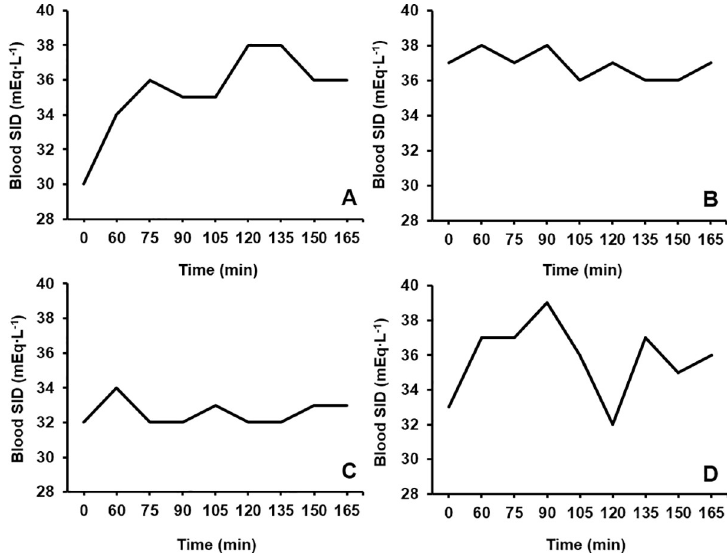
Fig 2. The time course change in blood strong ion difference (SID) over a 165 min period following NaHCO 3 ingestion for A) participant 10, B) participant 2, C) participant 12, and D) participant 3.